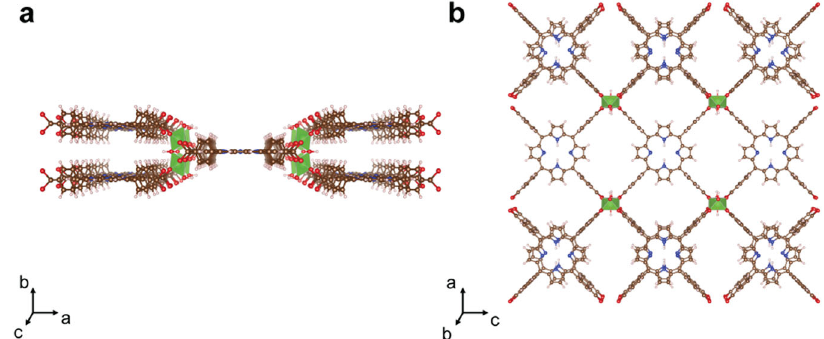
Fig. 1 Ball-and-stick representation of Al-PMOF. a View along the c -axis. b View along the b -axis. Color code: C (brown), O (red), N (blue), H (light pink), Al